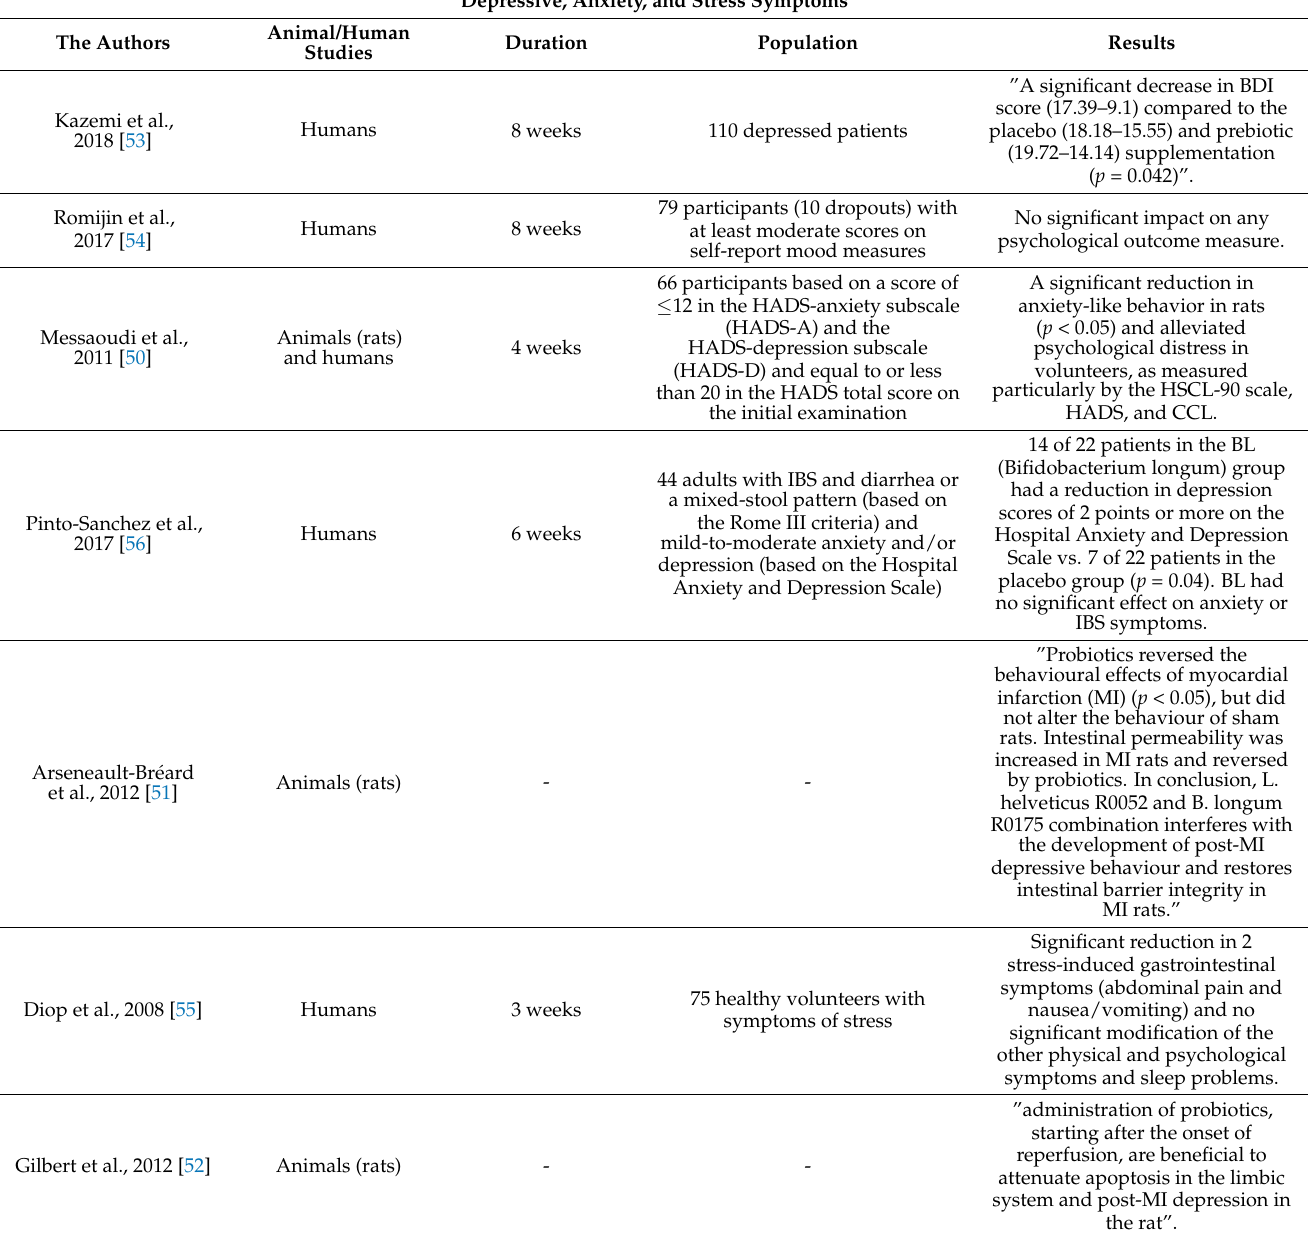
Table 4. The list of the recent clinical trials that demonstrated the efficacy of Bifidobacterium longum and Lactobacillus helveticus toward depressive, anxiety, and stress